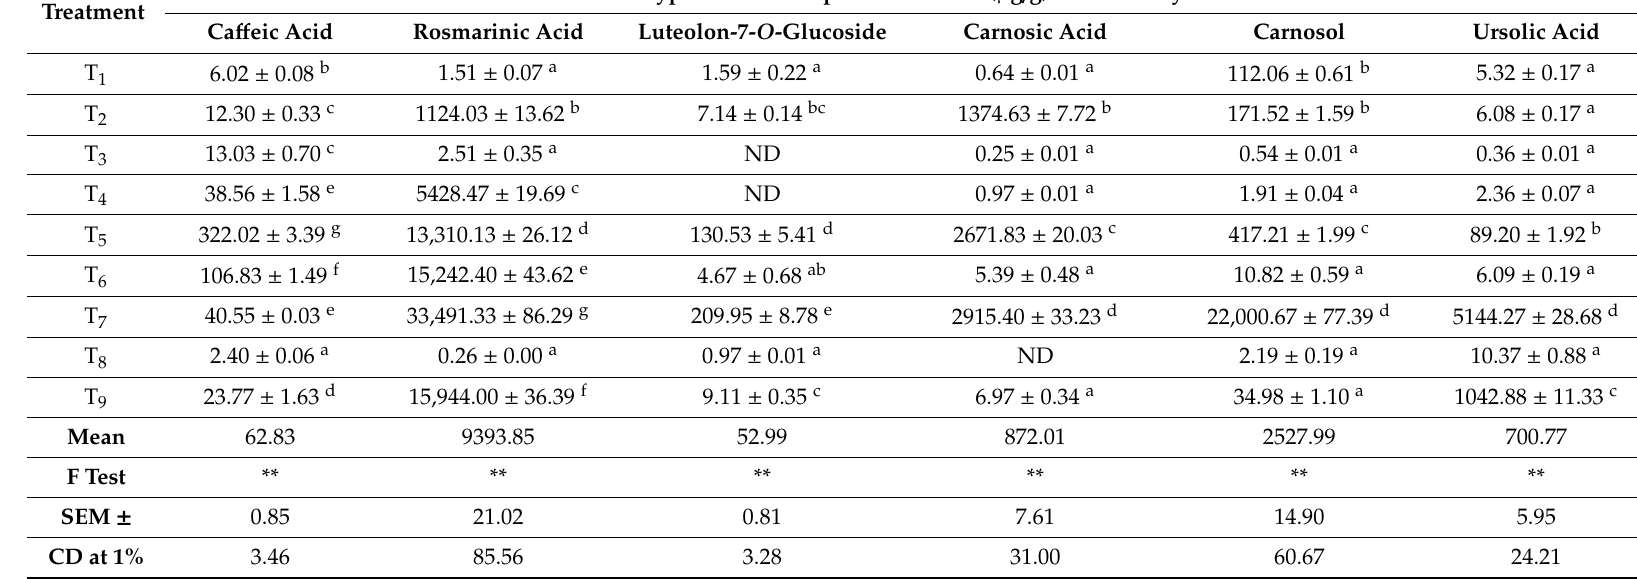
Table 1. Polyphenol and terpenoid content ( µ g / g) in di ff erent extraction of Rosemary analyzed by ultra-high-performance liquid chromatography and electrospray ionization, coupled with quadrupole-time of flight mass spectrometry (UHPLC-ESI-QTOF-MS). (Figures